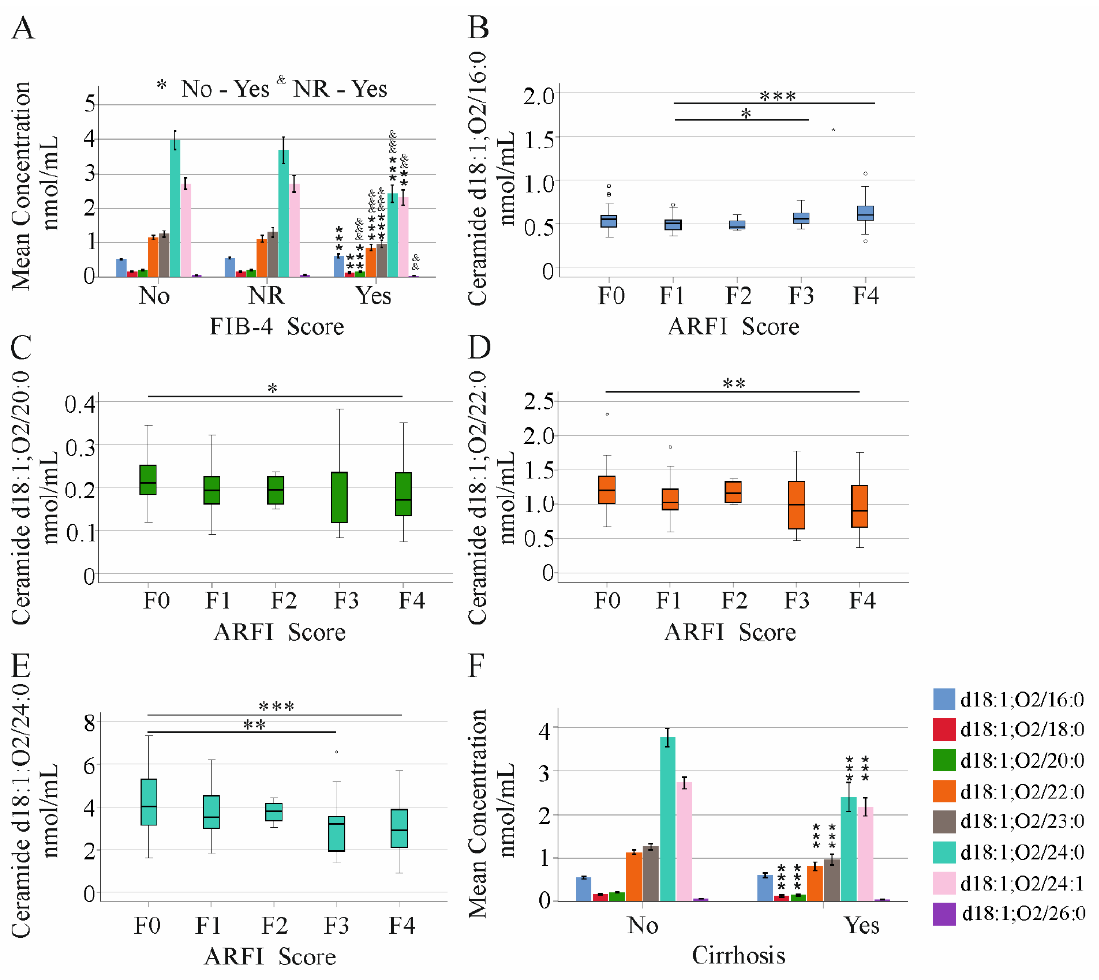
Figure 2. Ceramide species in relation to non-invasive fibrosis scores and liver cirrhosis diagnosed by ultrasound. ( A ) Mean concentration ± 95% confidence interval of ceramide levels in patients stratified for fibrosis by the FIB-4 score, (no fibrosis = No, 76 patients; not reliable values = NR, 52 patients; fibrosis = Yes, 50 patients); ( B ) median levels of ceramide d18:1;O2/16:0, ( C ) 20:0, ( D ) 22:0, and ( E ) 24:0 stratified for fibrosis by ARFI score (F0 = 69, F1 = 37, F2 = 11, F3 = 22, and F4 = 39 patients); ( F ) mean concentration ± 95% confidence interval of ceramide species in 138 patients without (No) and 40 patients with (Yes) liver cirrhosis diagnosed by ultrasound. * p < 0.05, ** p < 0.01, *** p < 0.001, & p < 0.05, && p < 0.01, &&& p < 0.001. Along the same lines, all but ceramide d18:1;O2/16:0 and 26:0 were reduced in